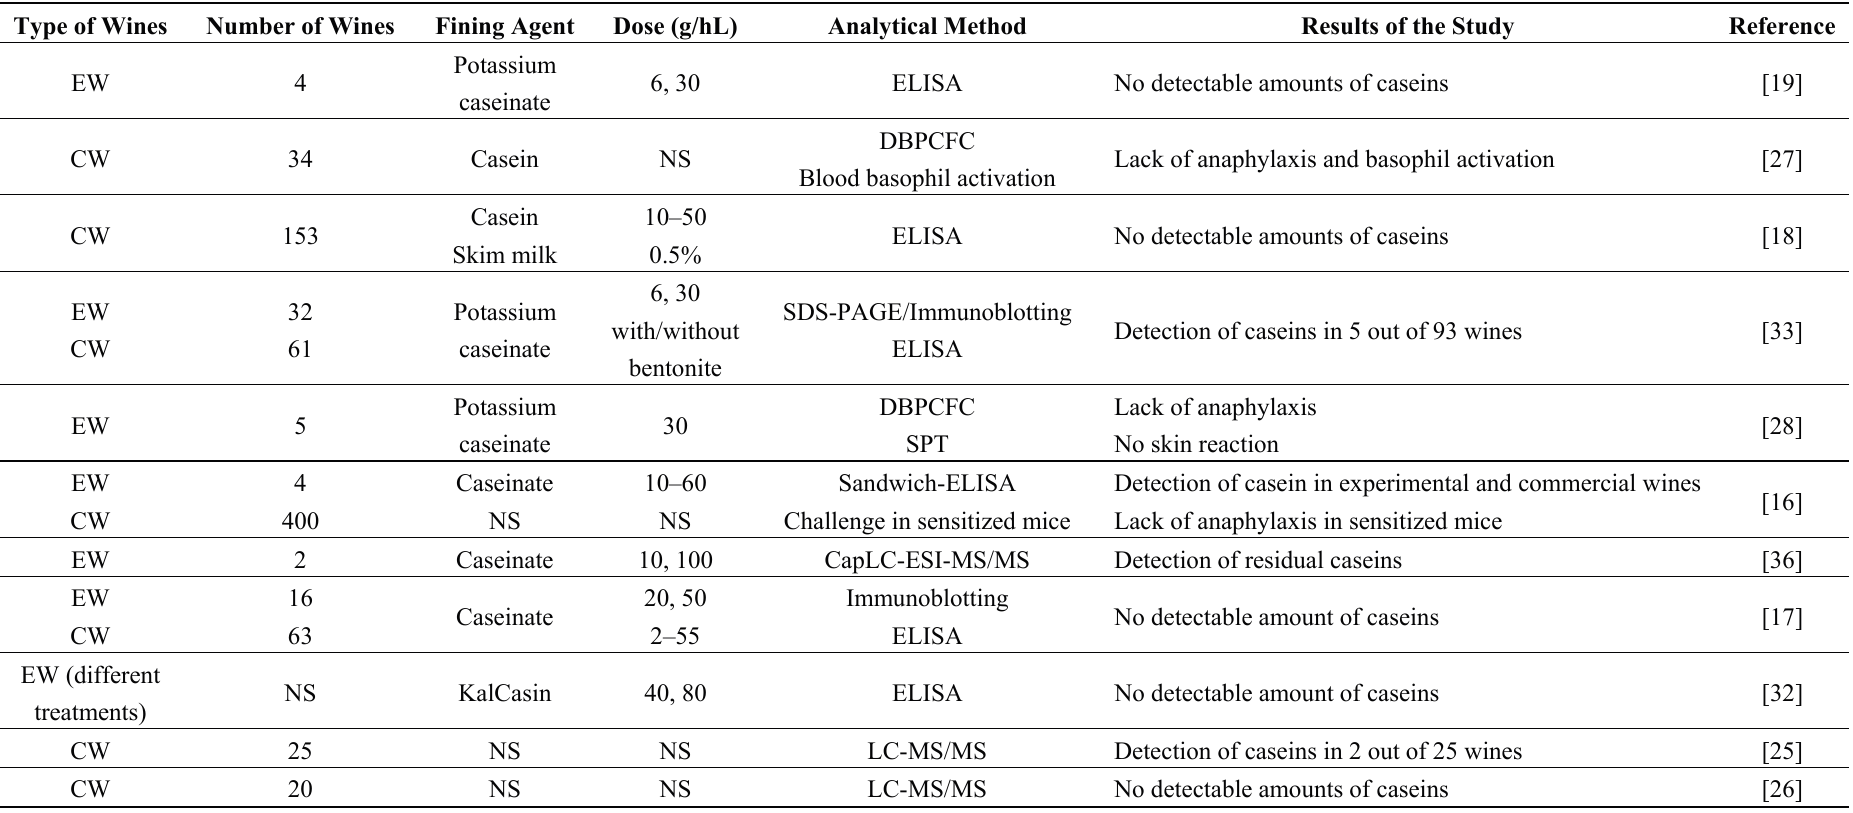
Table 4. Studies reporting data on allergenic residues in wines fined with milk